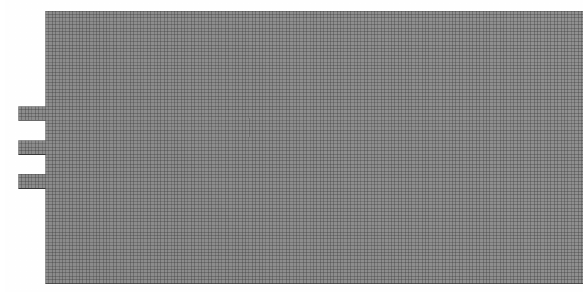
Figure 3: Meshing environment